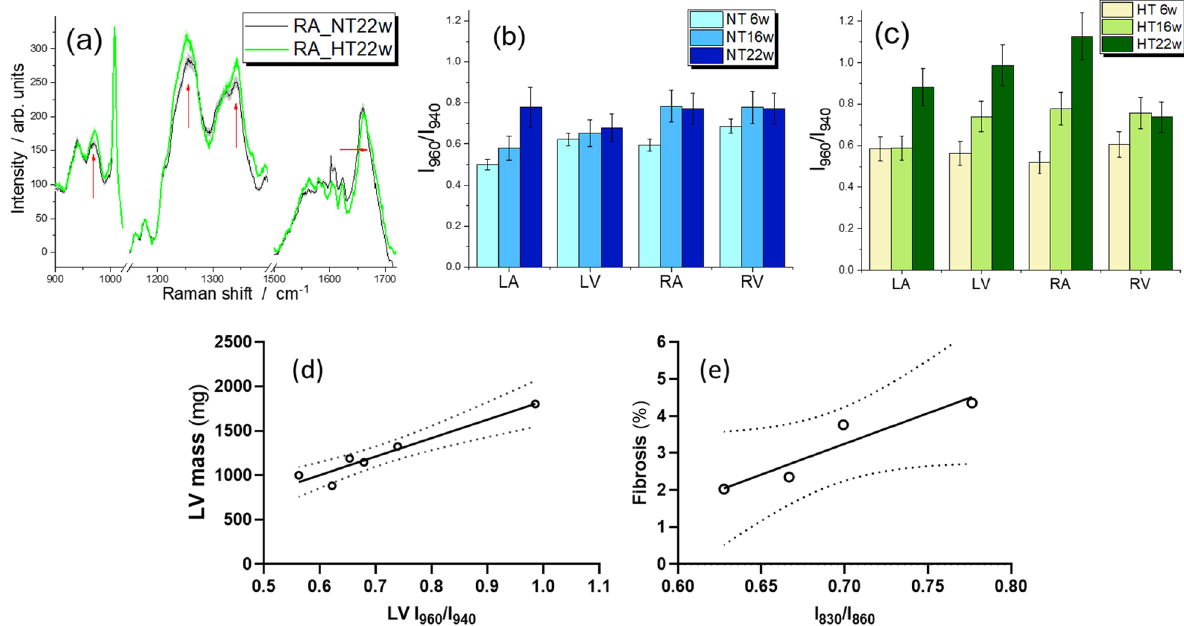
Figure 5. ( a ) Raman spectra of normotensive and hypertensive 22-week-old rats. Red arrows indicate significant changes between spectra of HT and NT samples. 960/940 cm −1 intensity ratio obtained from Raman spectra of ( b ) normotensive and ( c ) hypertensive rats at six- (6w), 16- (16w), and 22-week-old (22w) rats. Linear correlation between the LV I 960 /I 940 ratio and LV mass, and ventricular I 830 /I 860 ratio and interstitial fibrosis, with 95% confidence interval (dotted lines), is shown in ( d ) and ( e ), respectively. NT indicates normotensive Dahl/SS rat; HT, hypertensive Dahl/SS rat; LV, left ventricle; RV, right ventricle; LA, left atrium; and RA, right atrium. I 830 /I 860 I 960 /I 940 Variables r 2 p value p